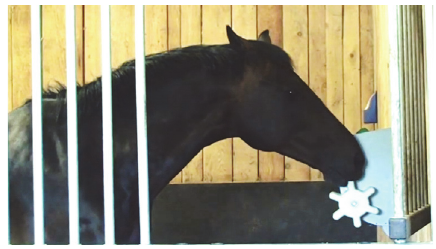
Figure 1: A horse approaches the dispenser